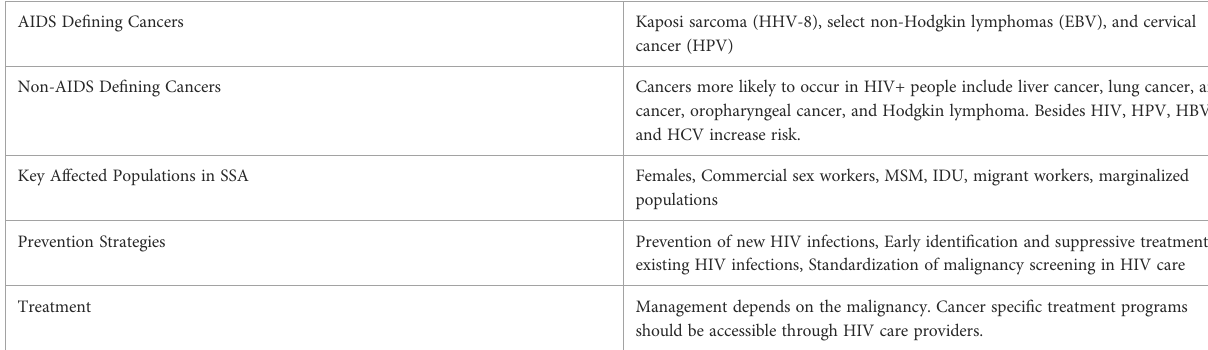
TABLE 7 HIV-associated